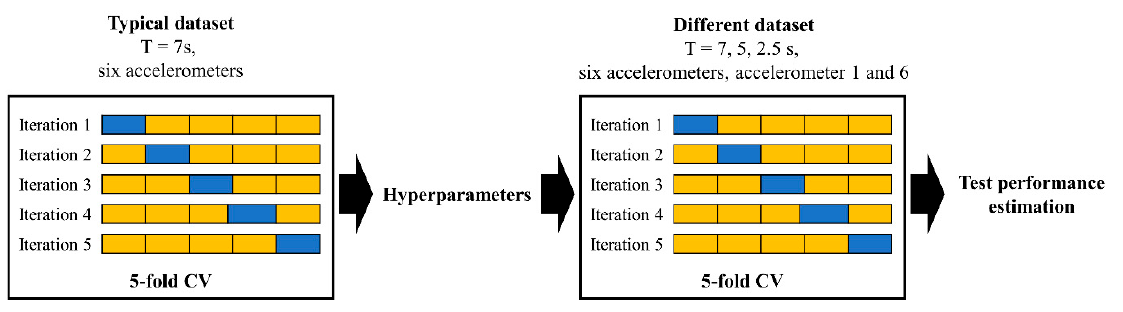
Figure 9. The process of 5-fold CV and estimating the test performance. The 5-fold CV performance is computed by averaging the 5 estimates of the test results. Based on the optimized hyperparameters using the typical dataset composed of 7-s-long signals with six accelerometers, the test performances are evaluated and compared with different test datasets.